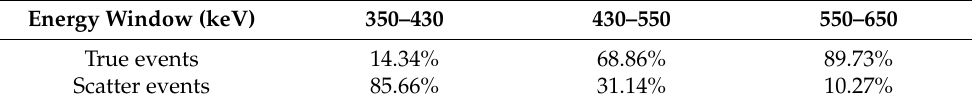
Table 1. Ratio of scatter-true events for each energy window (water-filled cylinder 16 cm).